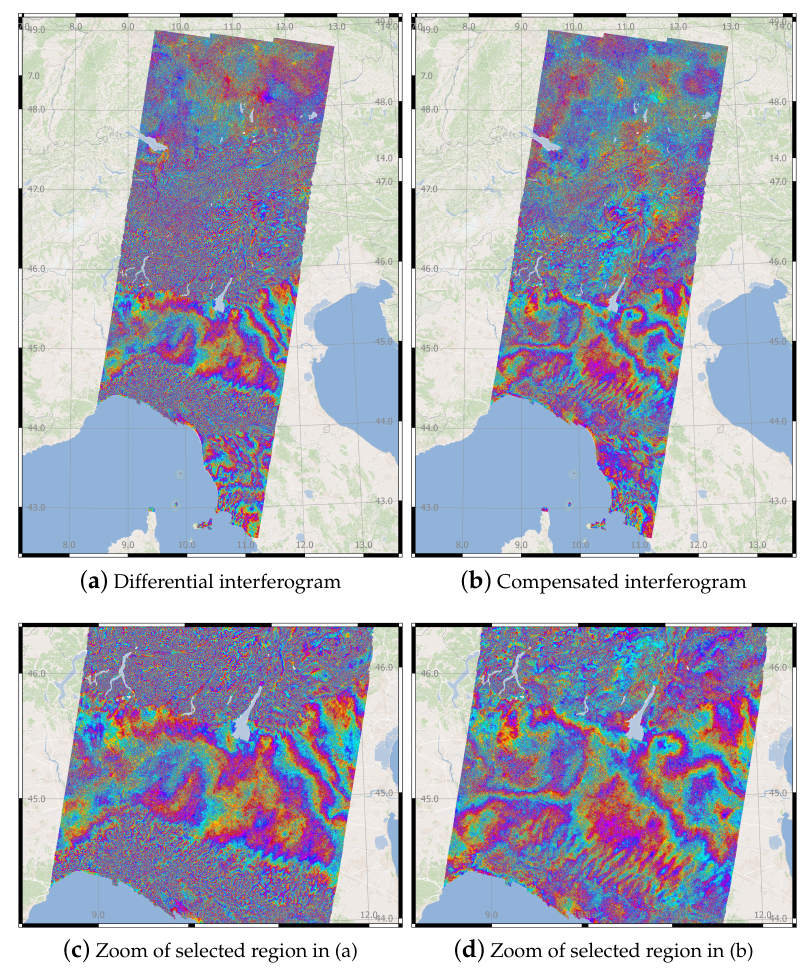
Figure 9. Eight Sentinel-1 images acquired in Interferometric Wide Swath Mode (IW) on 14 and 26 July 2016 at around 05:30 UTC. ( a ) Differential interferogram. ( b ) Atmospheric delays (tropospheric and ionospheric) and SET compensated interferogram. Zooms of the selected region around Po Valley provided in ( c , d ). Contains modified Copernicus Sentinel data 2016. Background: Data c (cid:13) OpenStreetMap contributors, Rendering c (cid:13)